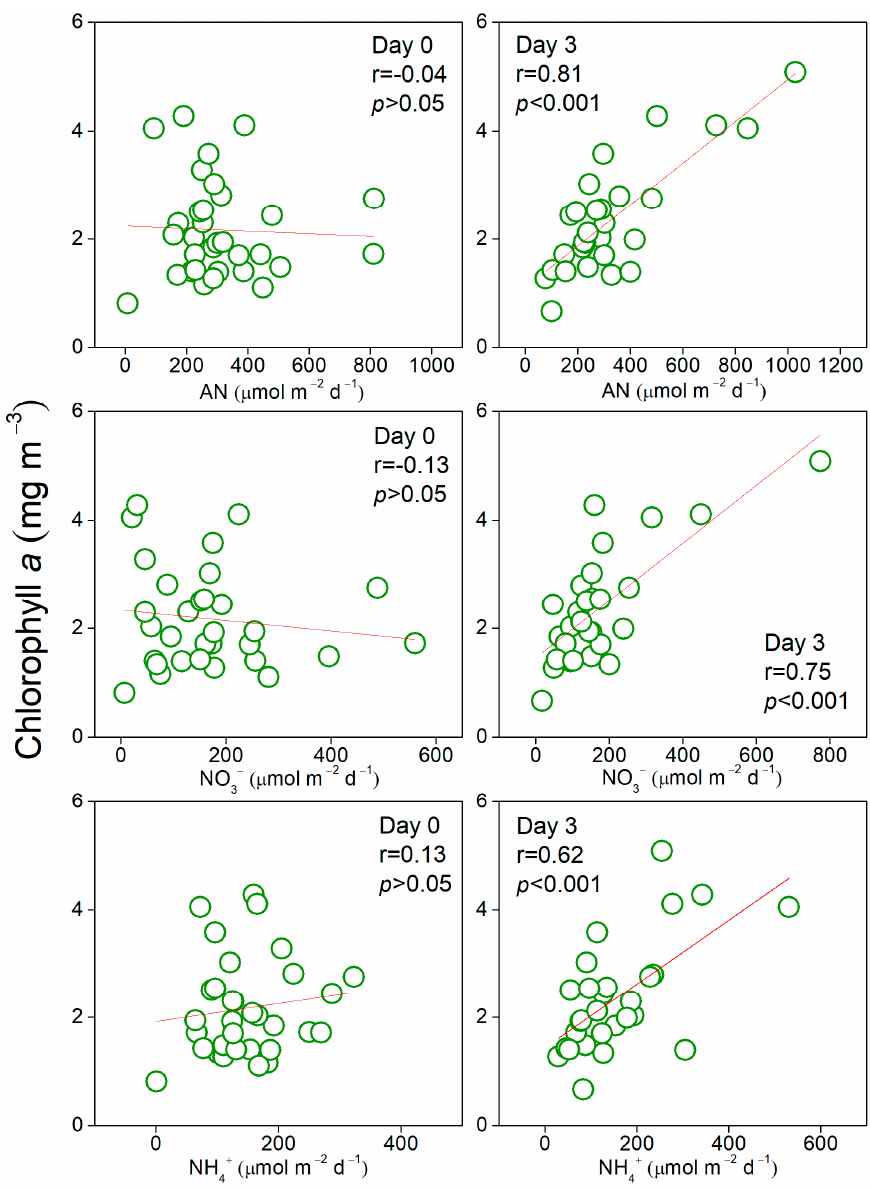
Figure 6. Correlations between Chl a and atmospheric dry deposition fluxes of nitrogen species in R3 on day 0 and day 3. AN is calculated as the sum of NH 4 + and NO 3 − . Weak correlation was observed between Chl a and P (Figure S7), while atmospheric P deposition should not be a critical predictor due to its very low content in aerosols and limited effect on Chl a as observed in the bioassay experiment. The lack of significant cor- relation between Chl a and Fe in R3 on day 0 was consistent with the previous result [65]. Although dust deposition is an essential source of Fe to the surface ocean [66], riverine input, shallow depth and upwells in the coastal area may largely erase the influence of atmospheric Fe input. Except for the coastal areas, the concentration of N in surface sea- waters of major part of the ECS is close to or below the proposed N limitation level of 2 μ mol L − 1 (Figure S6), the N deposition seemed to be a significant N sources and contrib- uted substantially to the primary productivity in the ECS. Zhu et al. calculated that at- mospheric N deposition could support 7.2% of the total primary production in the ECS, and this value might be tripled if wet deposition was included [26]. As the most abundant nitrogen species in atmospheric deposition (10 mmol m − 2 y − 1 vs. 6.1 mmol m − 2 y − 1 of NO 3 − ) [26], NH 4 + had the highest significance in predicting Chl a concentration, but it showed